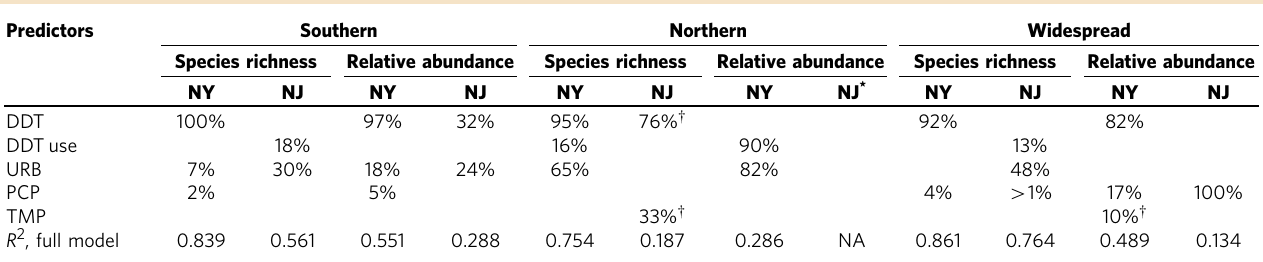
DDT, dichlorodiphenyltrichloroethane; NA, not available. Best regression model goodness-of-fit and variablecontributions are shown.Theexplanatory powerof models was measured via a pseudo- R 2 , calculated as: R 2 ¼ 1 (cid:2) [sum(model residuals)] 2 /[sum(null model residuals)] 2 , where the null model has an intercept and autoregressive terms. Significant ( P o 0.05) variables retained in the final regression model were removed from the model singly and per cent reduction in the resulting pseudo- R 2 compared with that of the final model is shownin the table. Higher values indicatevariableswithhighercontribution to the overallgoodness-of-fitof the model. The abbreviations designate DDTamount (DDT, Z -scores), DDTuse by the mosquito control districts (DDTuse), precipitation (PCP, standardized precipitation index), urbanization (URB, human population, in 100,000) and either an average annual November through October (widespread) or January temperature (northern) (TMP, (cid:2) C). For regression coefficients see Figs 6 and 7. *No significant predictors. w Significant main and quadratic